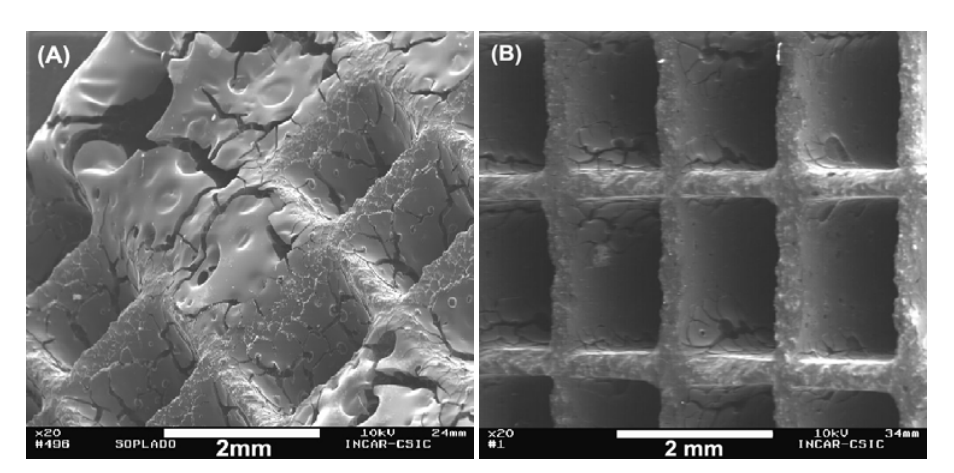
Figure 3. SEM microphotographs of carbon-coated HMs prepared by A: air blowing and B: spinning. From reference [20], with permission from